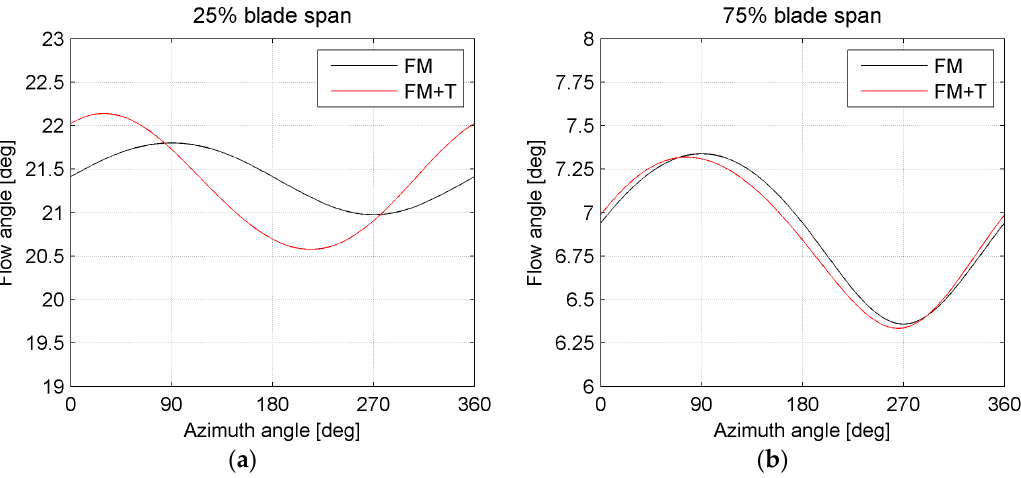
Figure 12. Computed flow angles at two different spanwise locations: ( a ) 25% and ( b ) 75% of the total span. Comparison between FM and FM + T configurations.